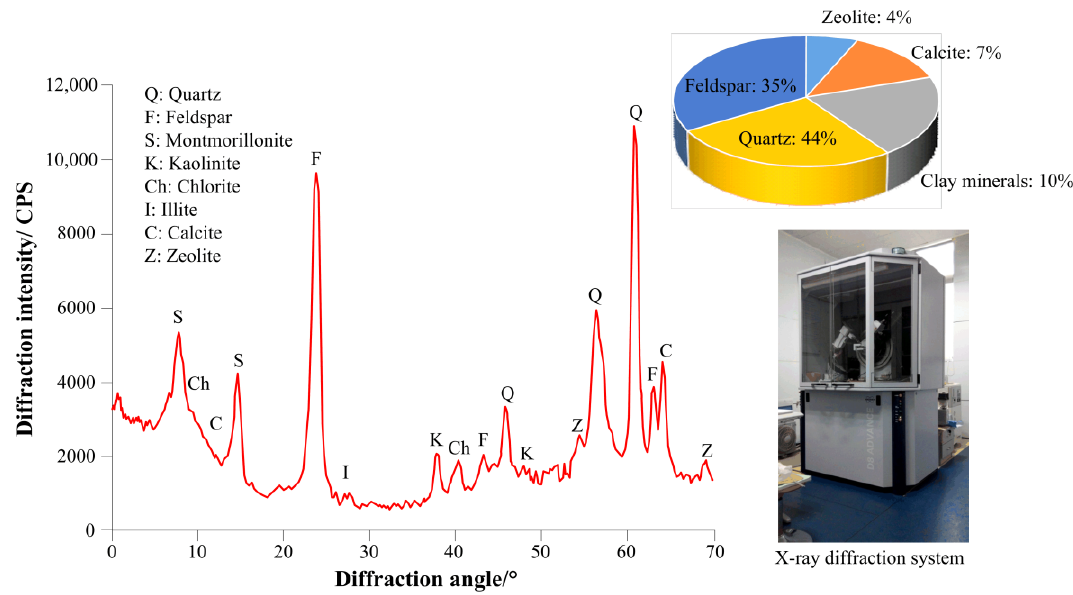
Figure 2. X-ray diffraction spectrum.